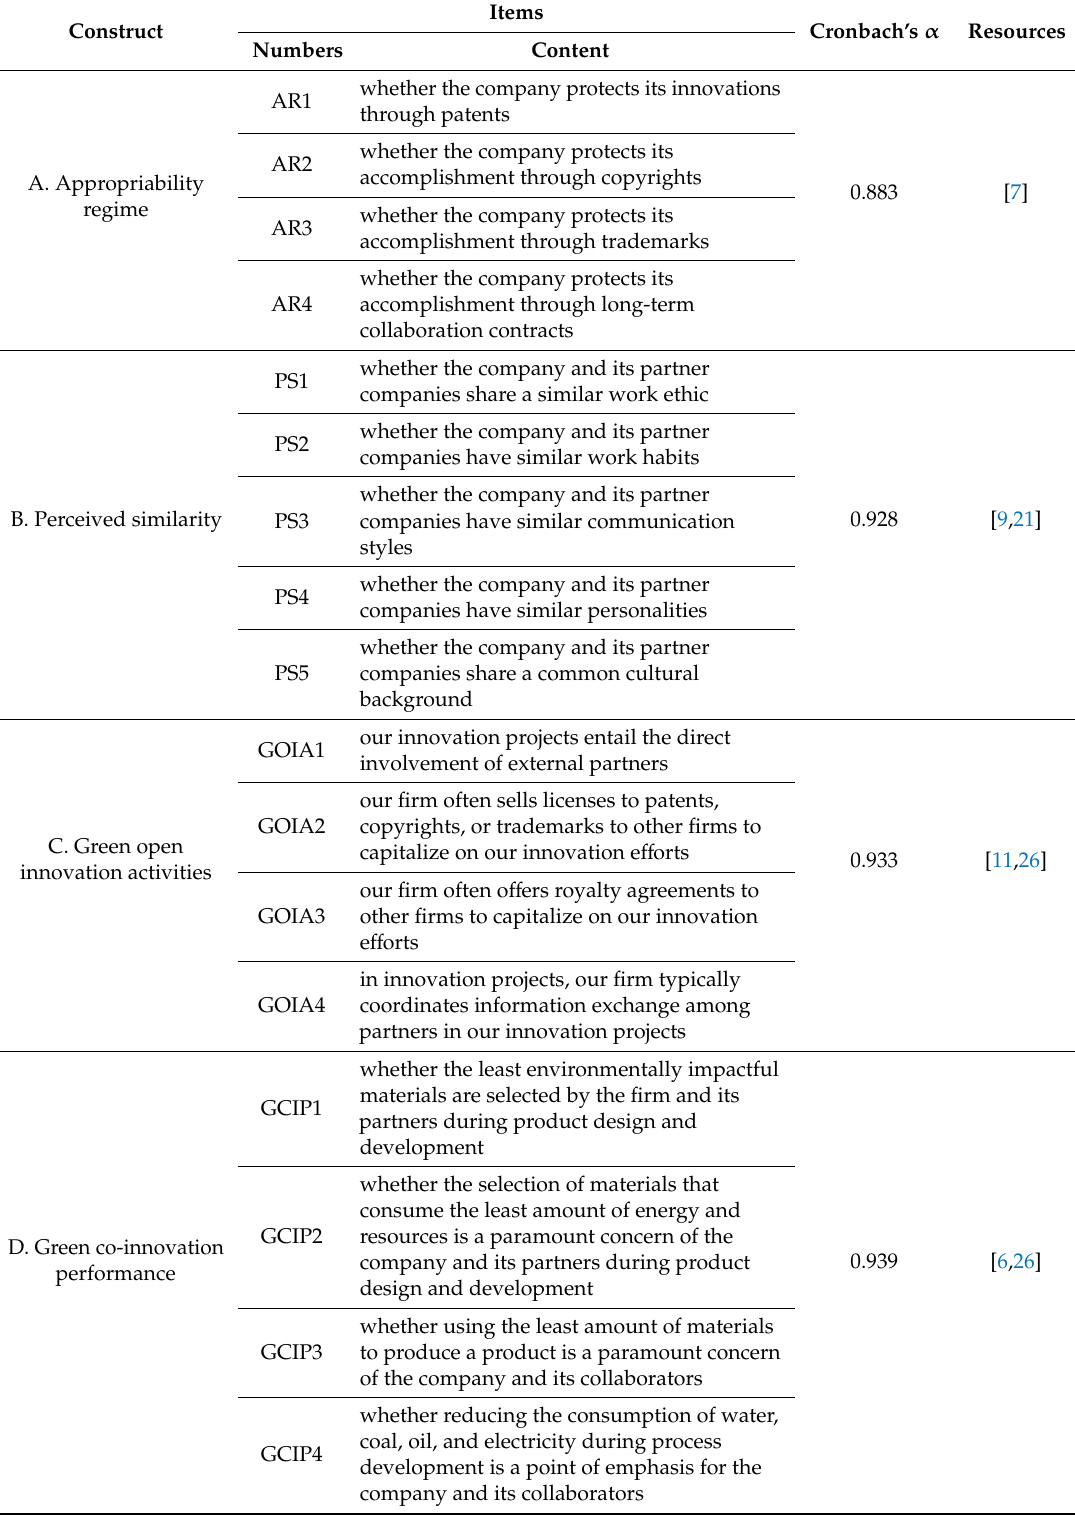
Table A1. The information on the